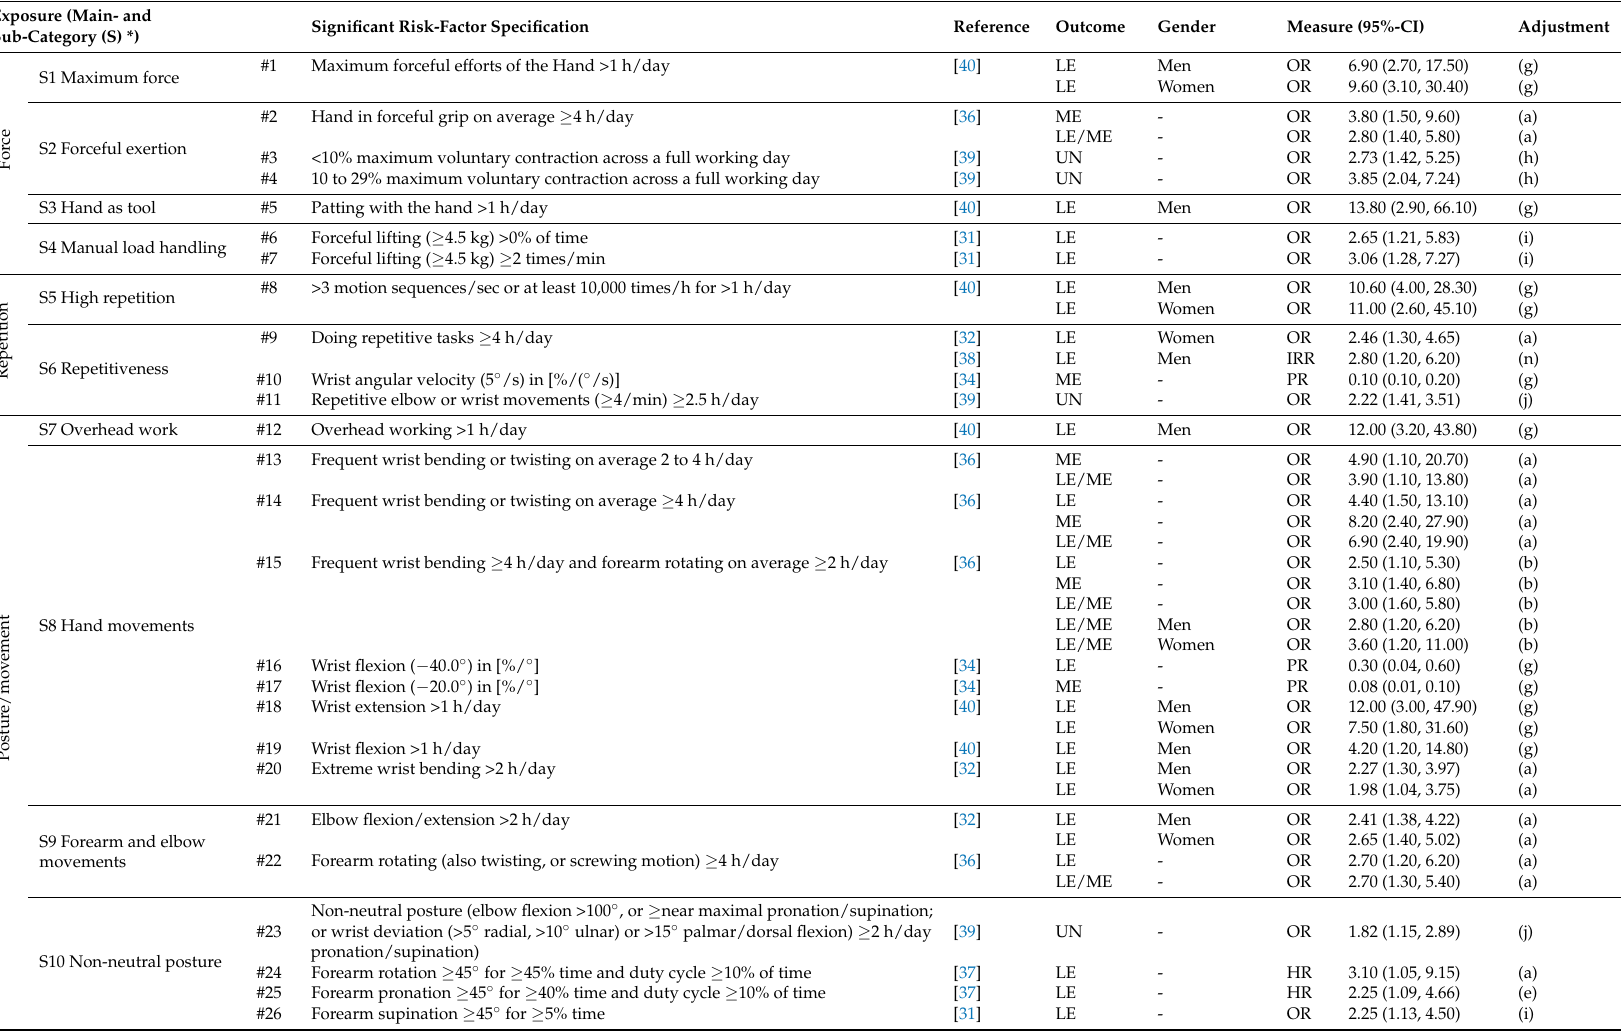
Table 4. Overview of relevant physical risk factors significantly associated with the development of specific disorders at the elbow.